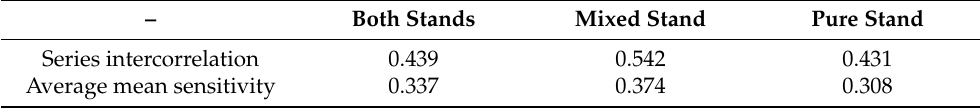
Table 3. Main dendrochronology